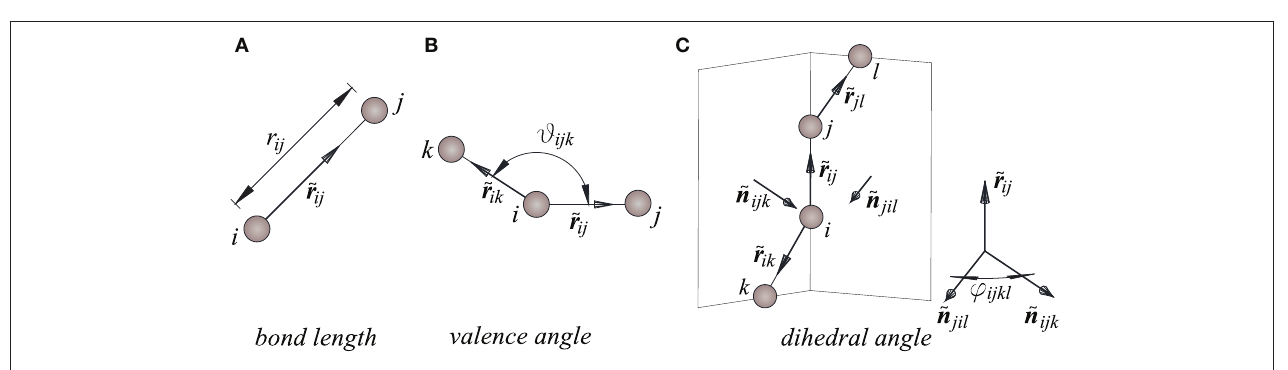
FIGURE 1 | The interatomic kinematics: (A) bond length, (B,C) valence, and dihedral